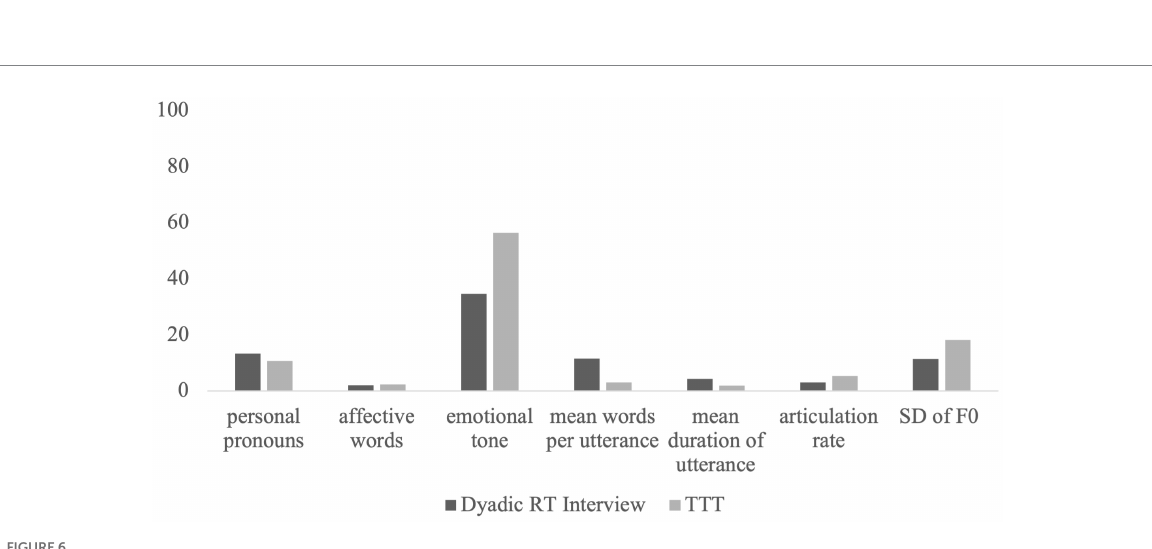
FIGURE 6 Mean of linguistic outcomes for Angela across two contexts: dyadic reminiscence therapy (RT) interview, and technology-driven group reminiscence therapy (TTT). The use of personal pronouns is measured as a percentage of all speech. Affective words incorporated both positive and negative emotive words and are measured as a percentage of all speech. The emotional tone is measured from 0 (most negative) – 100 (most positive). The mean words per utterance is a numerical count value. The mean duration of utterance is measured in seconds. The articulation rate is the number of words spoken per second calculated from utterances. The standard deviation of fundamental frequency (SD of F0) is measured in Hertz.